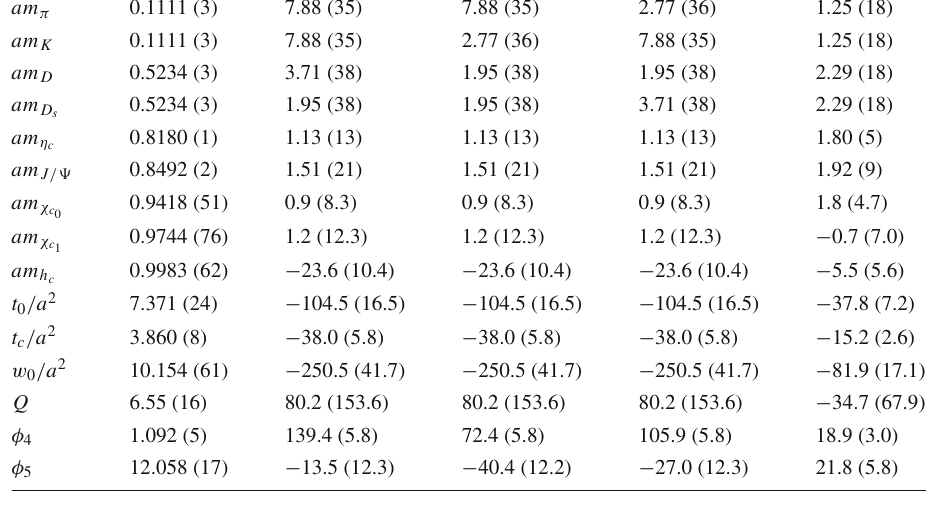
Table 11 Derivatives with respect to quark masses of pion/kaon, D - and D s -mesons and charmonium states η c , J /ψ , χ χ c 0 , c 1 and h c effective masses and flow observables on ensemble